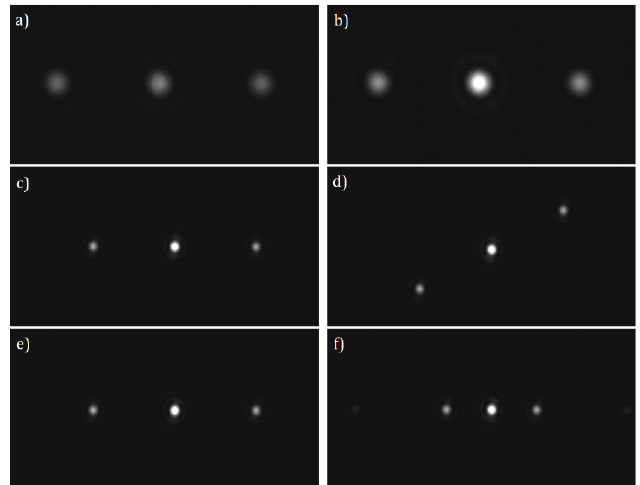
Fig. 4. Orders − 1, 0 and +1 diffracted by the DMD for different parameters of the displayed gratings. (a) and (b) The width of the slits varies from W = 26 . 3 to 65.75 µ m. (c) and (d) The angle of the grating varies from 0 to π/ 5 . (e) and (f) The period of the grating varies from G = 78 . 9 to 131.5 µ